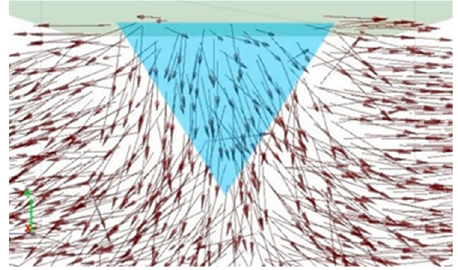
Figure 15. Force–displacement curve in numerical simulation. Figur e 15 . Force–displacement curve in numerical simulation Figur e 15 . Force–displacement curve in numerical simulation